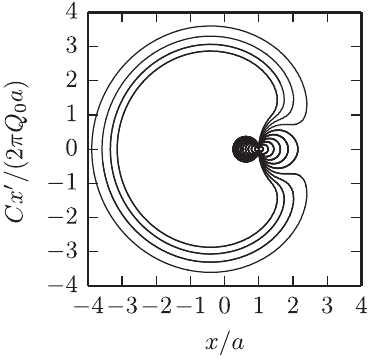
FIG. 8. Time evolution of the oscillation amplitude from sc ¼ simulations for bunches with Gaussian transverse and longi- tudinal distributions. Simulation parameters: q 0 . 01 Q s ¼